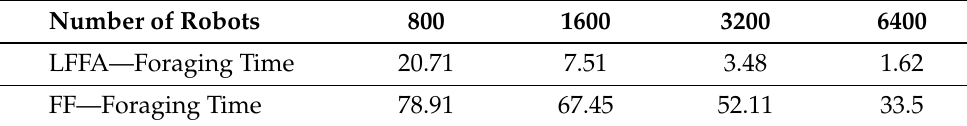
Table 7. Foraging time when varying the number of robot— Scenario 1 .